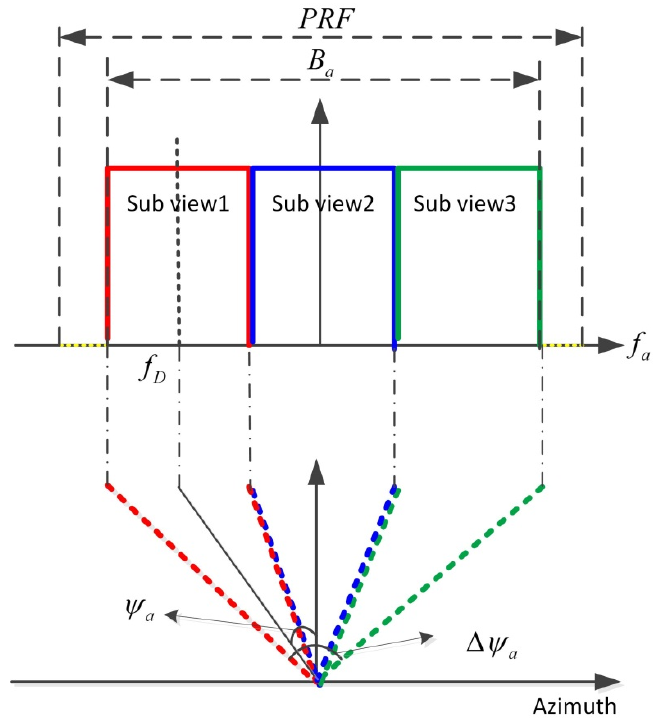
Figure 2. Schematic diagram of the frequency spectrum of PolInSAR data